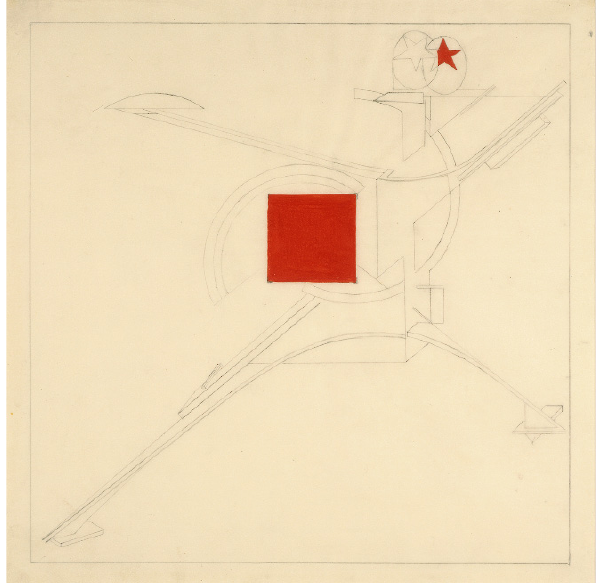
Figure 22. El Lissitzky, ‘The New Man’, drawing for the ‘Figurinnenmappe’, 1923. Van Abbemuseum. Photo: Peter Cox.